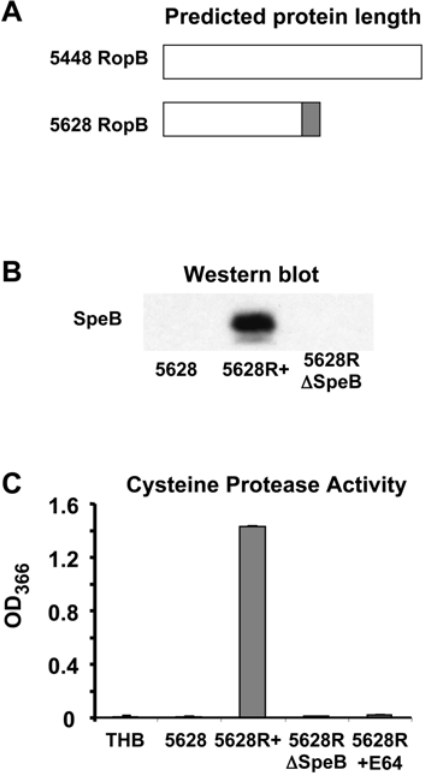
Figure 1. Mutation in ropB results in truncation of the RopB protein and abrogation of SpeB expression. (A) Schematic representation of the RopB protein expressed by GAS strains 5448 and 5628. In 5628, white region represent homology to 5448, shaded region indicates unique protein sequence in 5628. (B) Western blot for SpeB using overnight culture supernatants. (C) SpeB activity assay using azocasein substrate.